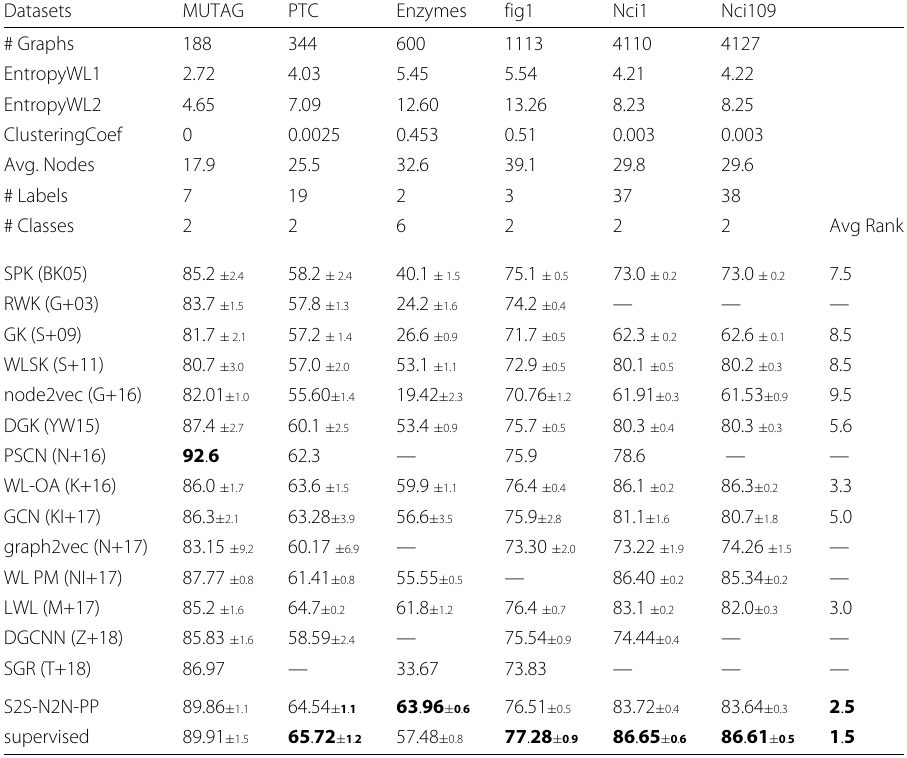
Table 1 Classification accuracies for labeled graph datasets